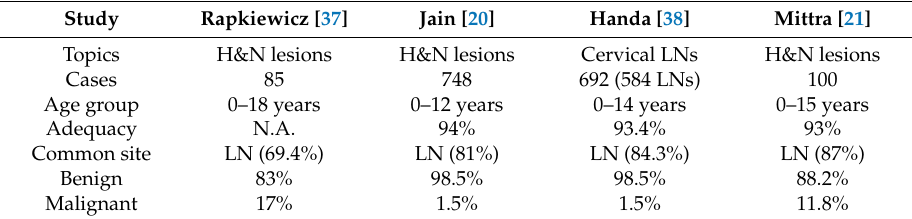
Table 2. Study Comparison (adapted from